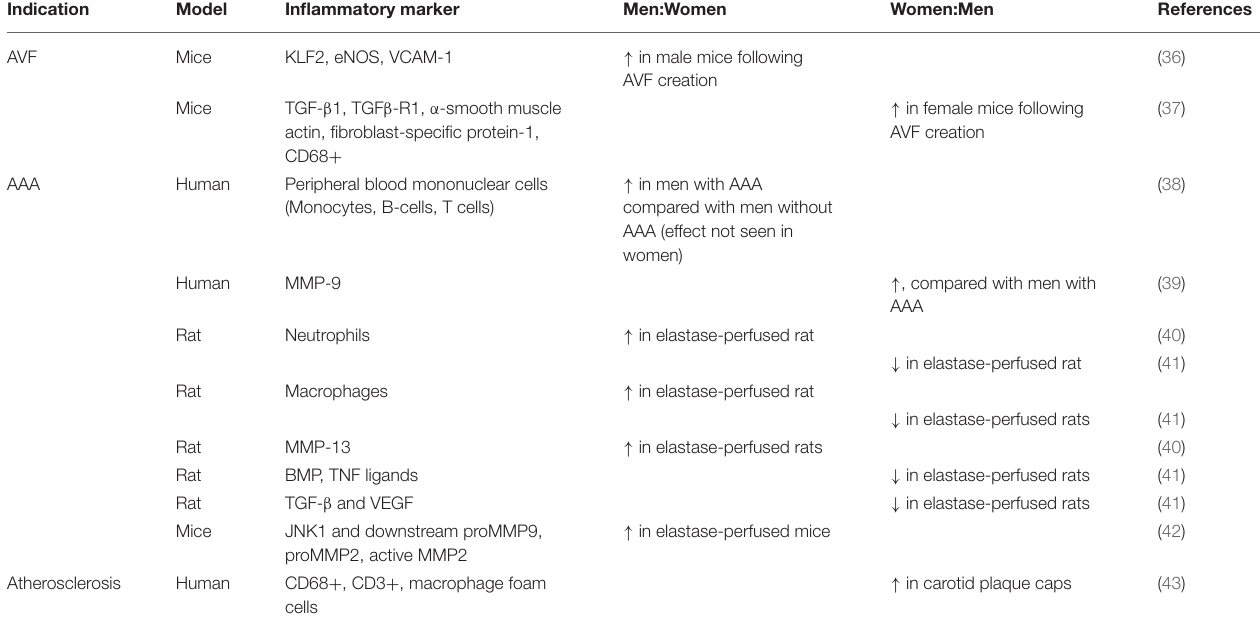
TABLE 1 | Observed sex differences in clinical studies and animal models.